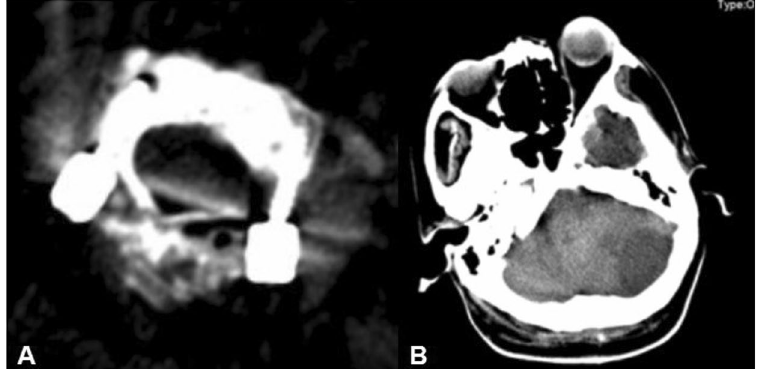
Figure 6. A 55 year-old female with atlantoaxial dislocation received free-hand C1 pedicle-C2 pedicle internal fixation. The bilateral vertebral arteries were involved, and the patient developed paralysis of the right upper and lower limbs approximately 4 hours postoperatively. A cerebral infarction was found in the computed tomography